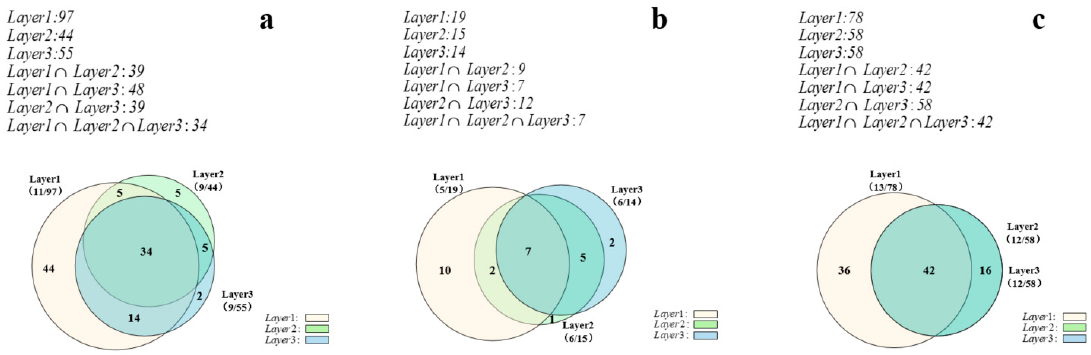
Figure 18. Distribution of overlapping edges in selected areas: ( a ) area1, ( b ) area2, and ( c ) area3.